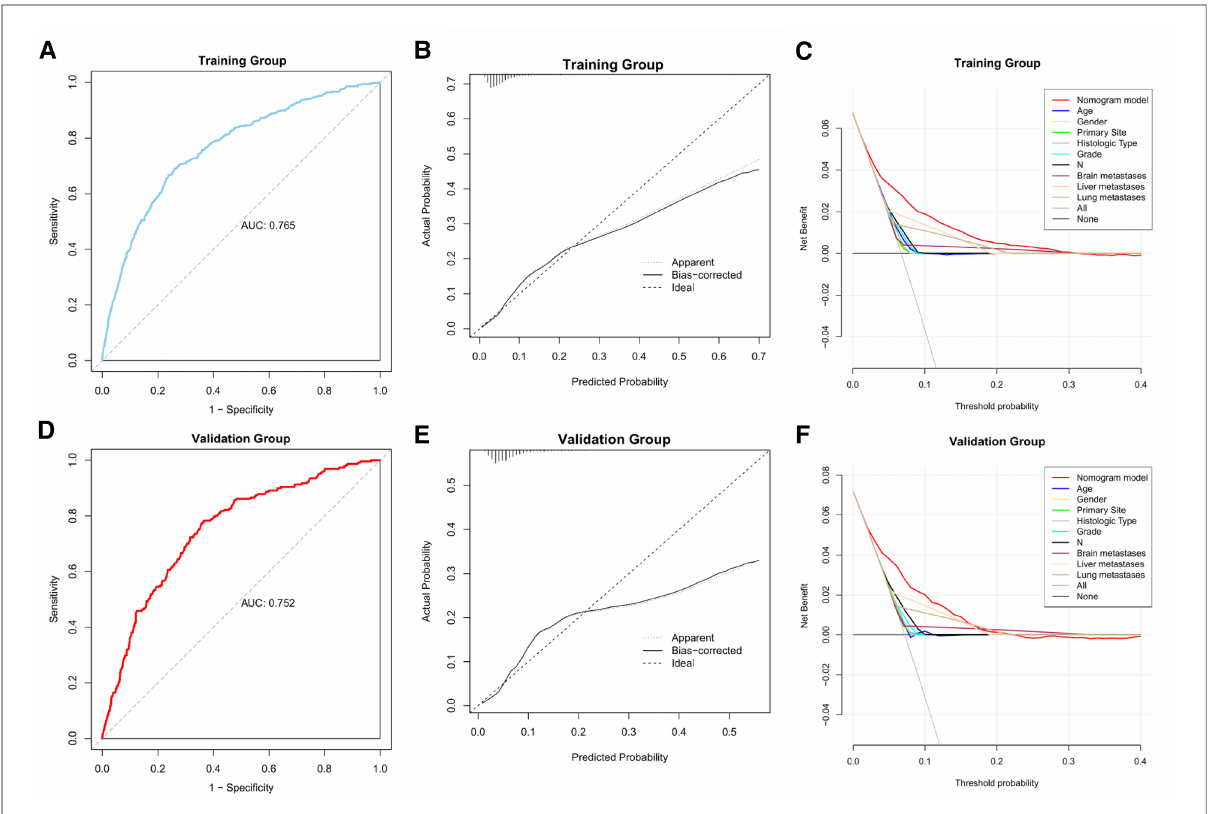
FIGURE 3 ROC, calibration, and DCA curves of the predictive model in the training and validation groups.